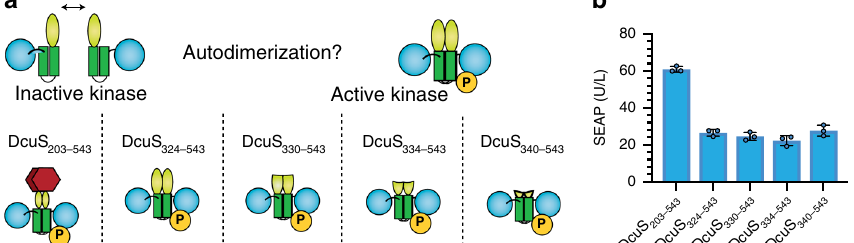
Fig. 2 Reducing DcuR autodimerization by generating truncation mutants. a Schematic of DcuS truncation mutants. b Reporter gene expression in response to expression of different DcuS N-terminal truncation variants together with DcuR-VP16. The bar chart shows the mean ± s.d. of n = 3 biologically independent samples overlaid with a scatter dot plot of the original data points, measured 24 h after transfection, and the results are representative of three independent experiments. Source data are provided as a Source Data fi le. to high reporter gene expression. Variants lacking the PAS P SV40 -DcuR-VP16-pA ). To quantify DcuS activity, we designed a reporter plasmid containing DcuR-speci fi c-binding sites 34 (DcuR response elements; RE) upstream of a minimal promoter that (Fig. 2b). The basal reporter activity can likely be attributed to a drives expression of the reporter protein, secreted alkaline combination of promoter leakiness, residual DcuS dimerization, phosphatase (SEAP; DcuR-RE 8x -P hCMVmin -SEAP-pA ; Fig. 1d). The and uninduced DcuR binding to its response elements. These complete intracellular domain of DcuS ( P SV40 -DcuS 203-543 -pA ) led NATURE COMMUNICATIONS| (2020) 11:3085